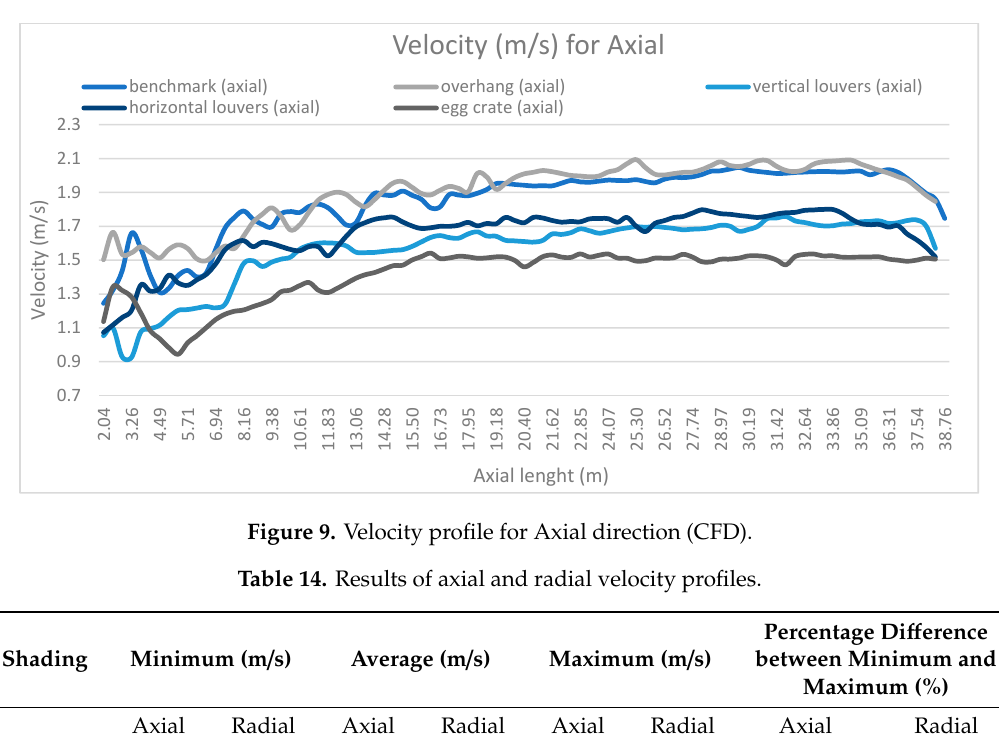
Table 14. Results of axial and radial velocity profiles.